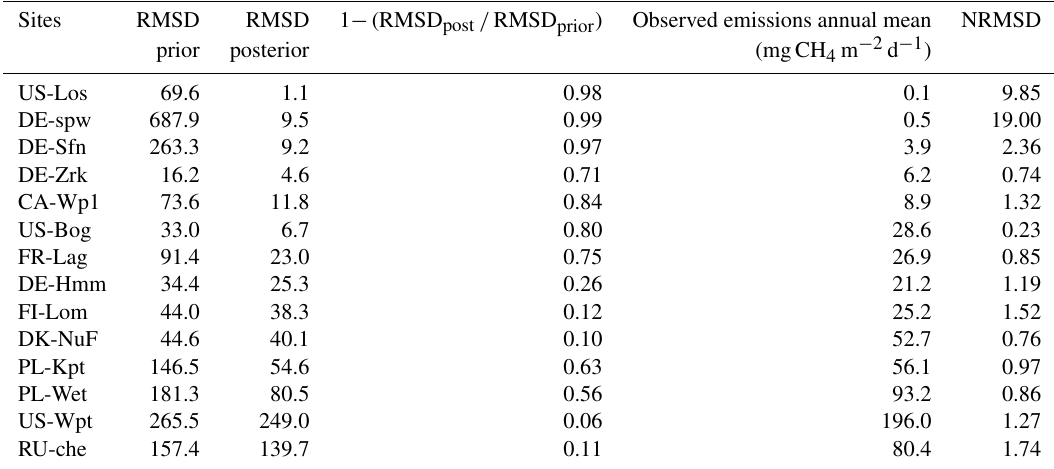
Table 5. Discrepancies between observed and simulated methane emissions are quantified by the root mean square difference (RMSD) approach. Minimization efficiency of each test is indicated by the relationship between the prior using default values and posterior RMSD as (1 − RMSD post / RMSD prior ) × 100. Normalized root mean square difference (NRMSD) is defined by the RMSD posterior normalized by the annual mean of observed methane